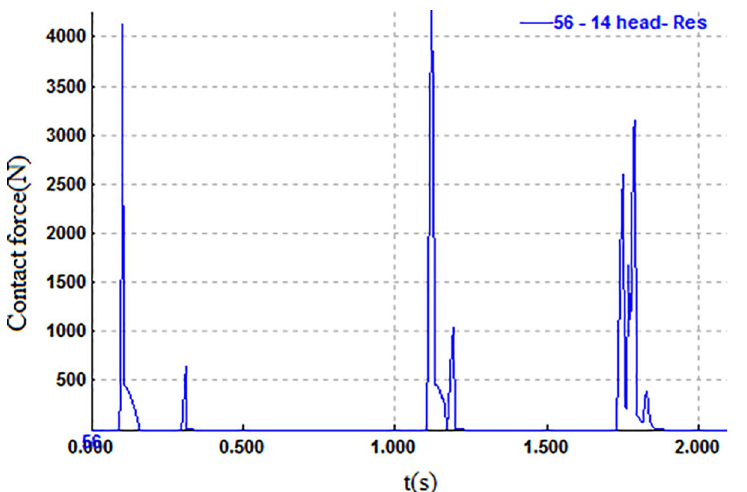
Fig 6. Contact force curve of pedestrian